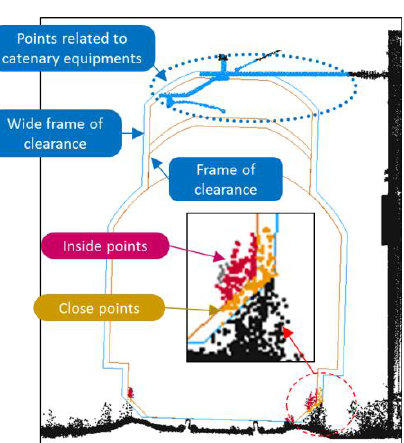
Figure 13. Examples of extracting rails